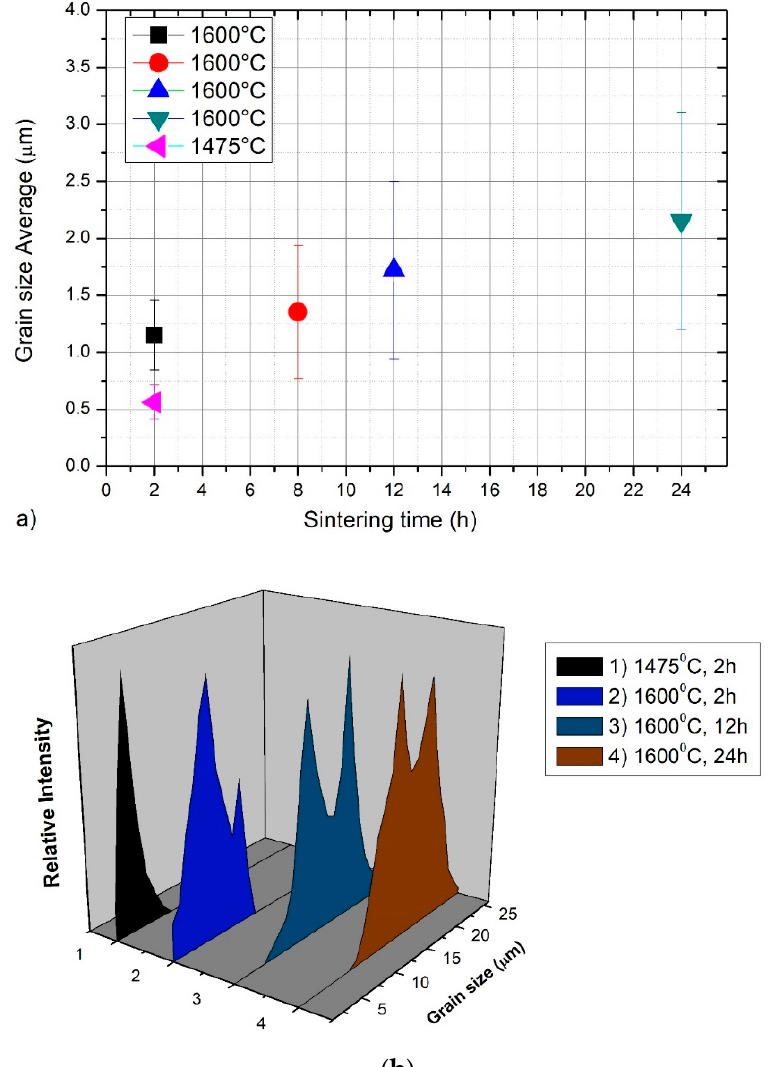
Figure 6. ( a ) Average size of zirconia grains as a function of the proposed sintering cycle. ( b ) Grain size distributions of sintered ZrO 2 .